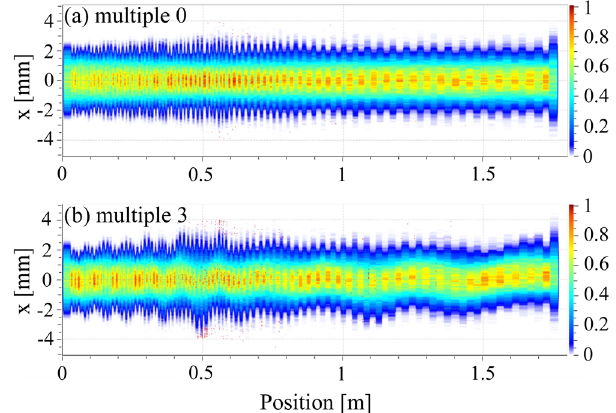
design.FIG. 23. Beam envelopes at (a) multiple 0 and (b) multiple